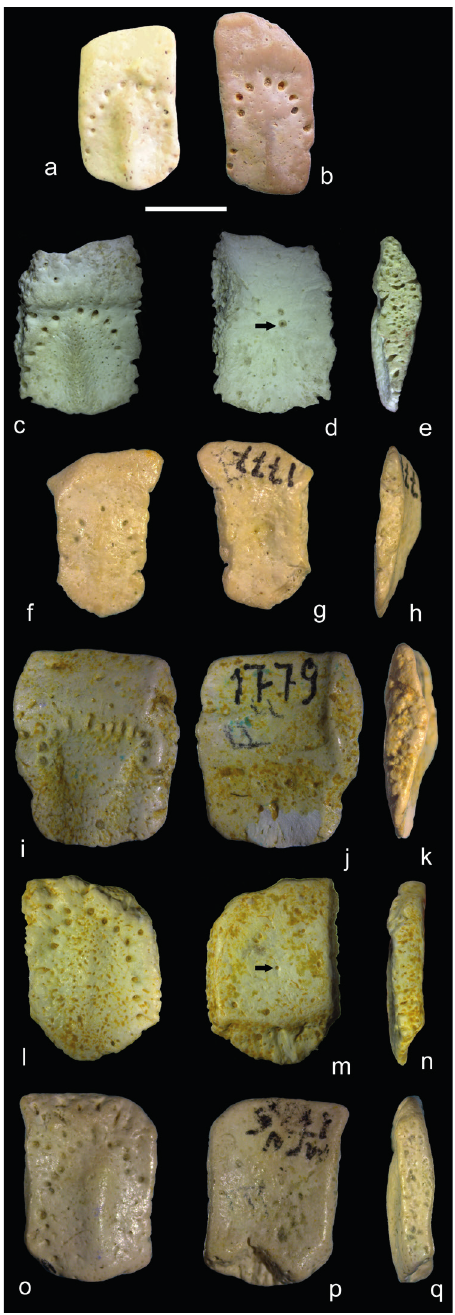
Figure 1 - Movable (a-k) and buckler (l-q) osteoderms of Riostegotherium yanei , a) LMh 05 and b) UFrJ-DG 317M in external view; c-e , LMh 06; f-g , MCN-PV 1777; i-k , MCN-PV 1779; l-n , MCt 3932-M; o-q , MCN-PV 1775. Scale bar = 5 mm. c , f , i , l , o in external view; d , g , j , m , p in internal view; e , h , k , n , q in lateral view. Anterior to the top, dorsal to the left. Black arrows indicate foramina of the deep